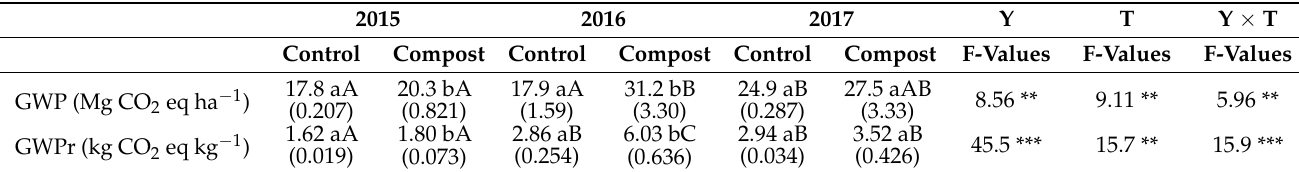
Table 4. Effect of the different management systems for the global warming potential and the global warming potential based on the agronomic yield of rice during the rice cultivation cycle. Mean value and standard error of 3